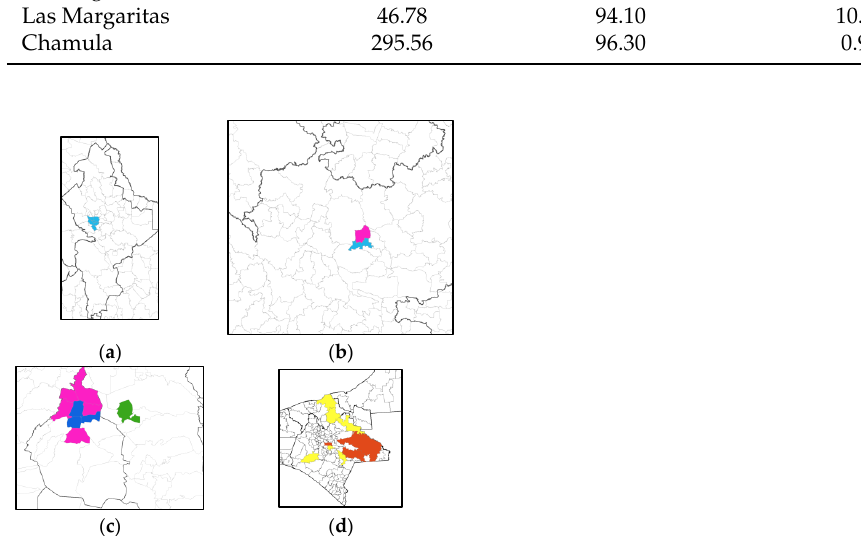
Figure 6. Magnified neighborhoods of municipalities. ( a ) Nuevo León. ( b ) Jalisco. ( c ) CDMX. ( d ) Chiapas.